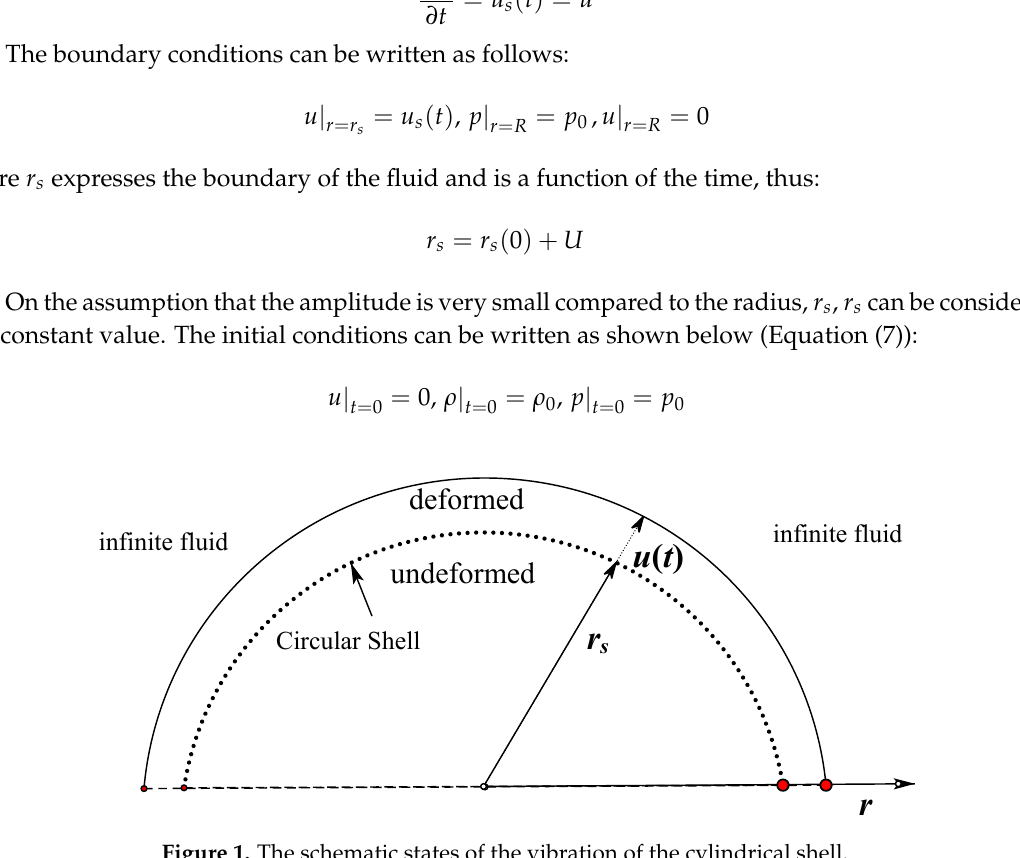
Figure 1. The schematic states of the vibration of the cylindrical shell.